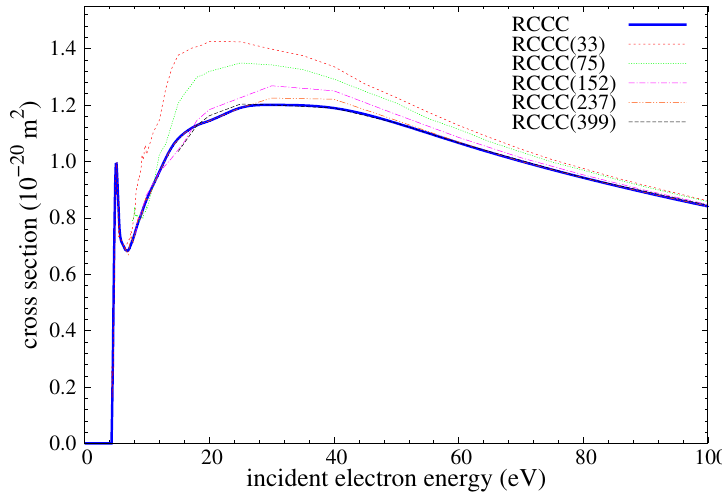
Figure 12. Convergence of the RCCC-integrated cross section with number of states included. Only shown for the 5 p 2 3 P 0 5 p 6 s 3 P ○ 1 dipole-allowed transition. (cid:1)